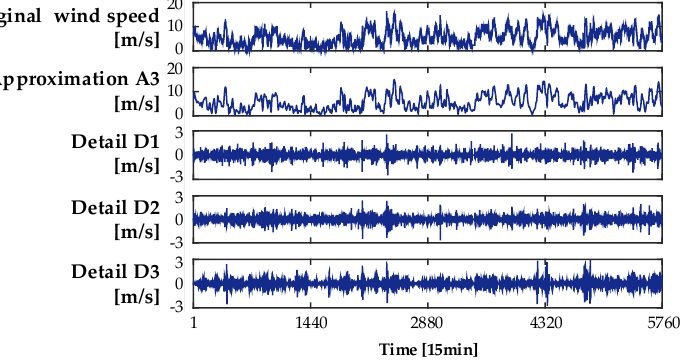
Figure 5. Original wind speed series and its decomposed series.